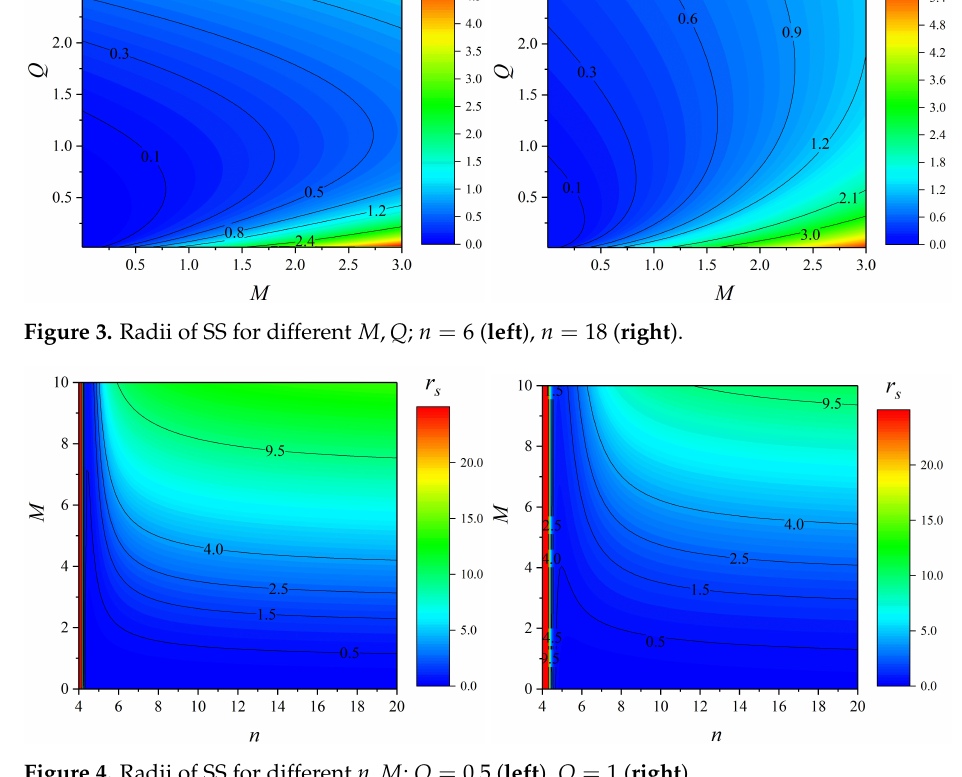
Figure 4. Radii of SS for different n , M ; Q = 0.5 ( left ), Q = 1 ( right